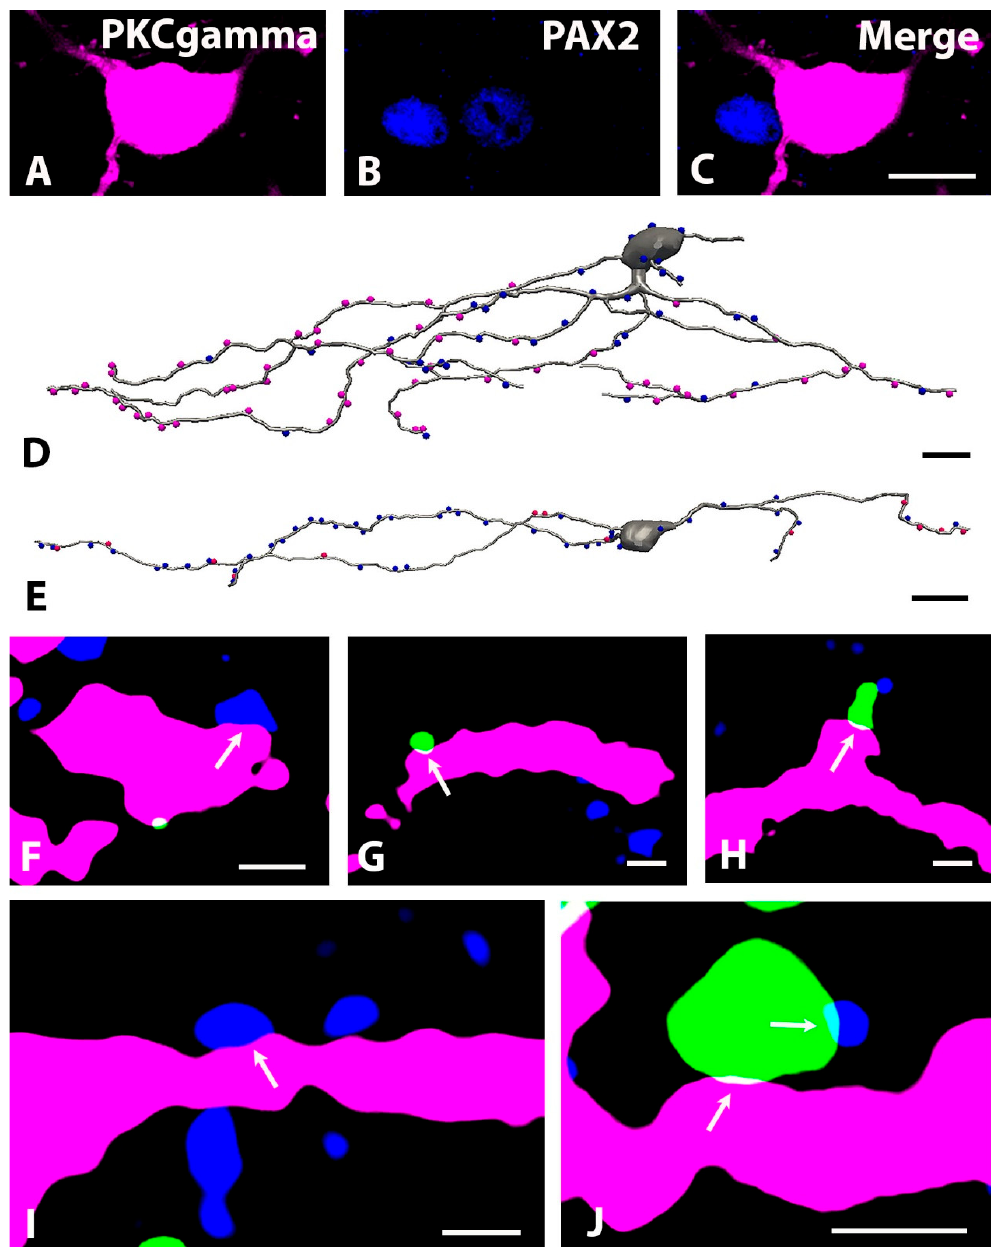
Figure 10. Close appositions between unmyelinated (IB4-binding) and myelinated (VGLUT1 im- munostained) primary afferents as well as GlyT2 immunoreactive axon terminals on tdTomato-labeled neurons in Prkcgtm2/cre/ERT2-tdTomato mice. ( A – C ): Micrographs of a single 1 µm thick laser scanning confocal optical section showing PAX2 (blue) immunostaining of the nucleus of a tdTomato (magenta) labeled PKC γ -containing neuron. ( D – E ): Camera lucida reconstruction of the dendritic trees of PKC γ (gray)-containing neurons making close appositions with GlyT2 (blue) im- munoreactive as well as IB4-binding ( D ) and VGLUT1 ( E ) immunostained axon terminals (ma- genta). ( F – J ): Micrographs of 1 µm thick laser scanning confocal optical sections showing close ap- position between tdTomato (magenta) labeled dendrites of PKC γ -containing neurons and VGLUT1 (green; ( G , H , J )) or GlyT2 (blue, ( F , I )) immunoreactive axon terminals. Note that the VGLUT1 im- munoreactive axon terminal forms a close apposition with a tdTomato-labeled dendrite in inset ( J ) contacted by a GlyT2 immunostained axon terminal. Arrows indicate the sites of close appositions between the labeled structures. Bars: 10 µm ( A – E ),1 µm ( J ) 0.5 µm ( F – I ).